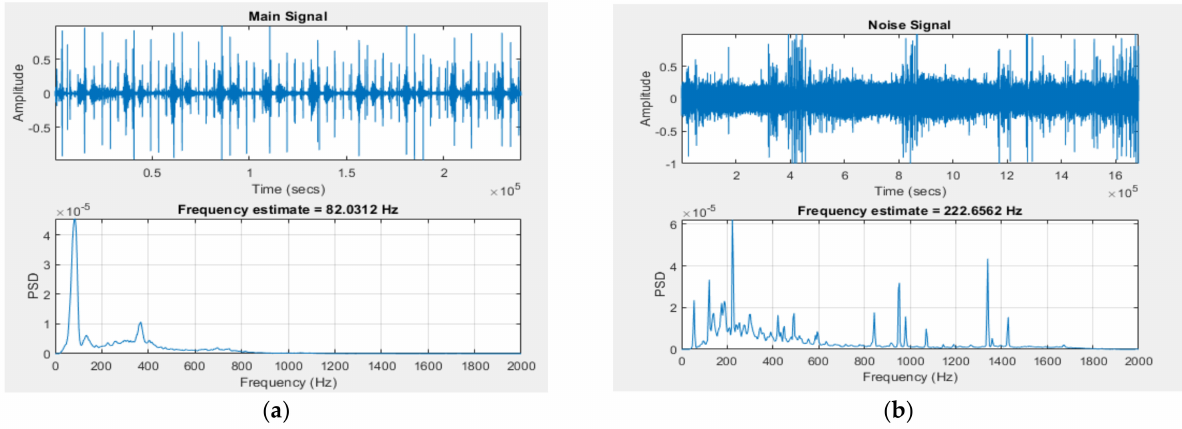
Figure 15. ( a ) Main signal and its power spectral density; ( b ) noise signal and its power spectral